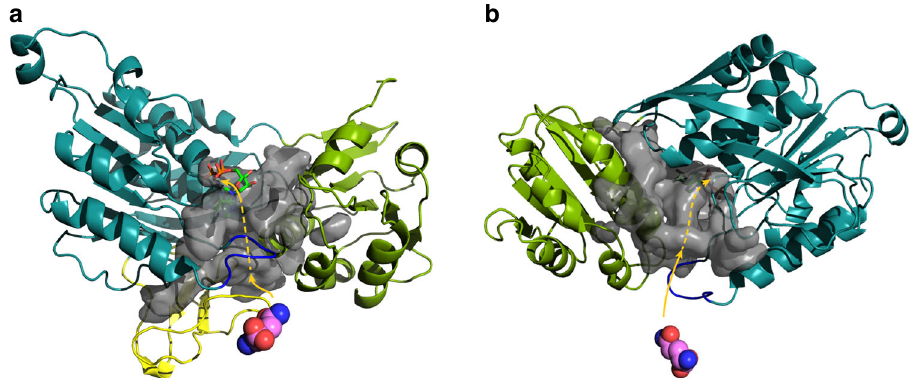
Fig. 8 Putative channels allowing the transfer of ammonia inside MurT. Front ( a ) and back ( b ) view with the zinc-ribbon-like region removed to allow better view. The color scheme of the domains is as in Fig. 3. The modeled loop 137 – 141 is shown in blue. The glutamine in the GatD active site is shown as atom- colored spheres. The cavity surface is in transparent gray with a possible path of the ammonia